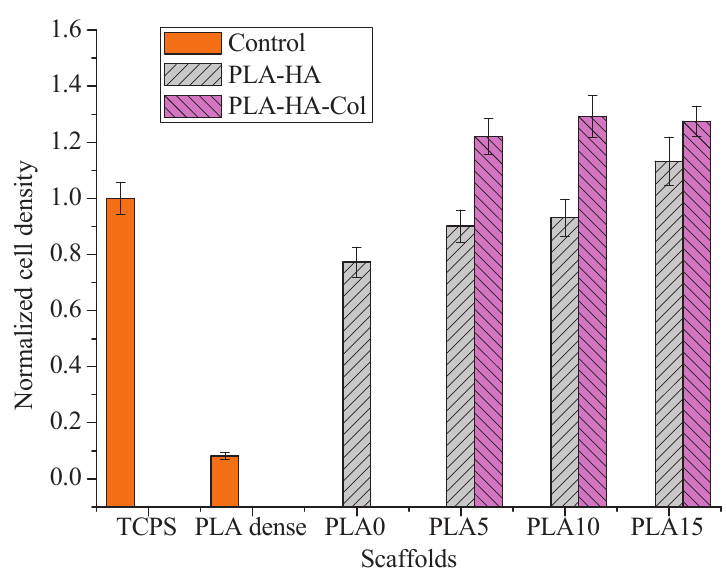
Figure 11: LDH results for cell density on pristine (dense PLA scaffold), PLA-HA scaffold and PLA-HA-Col scaffold at different concentrations of HA